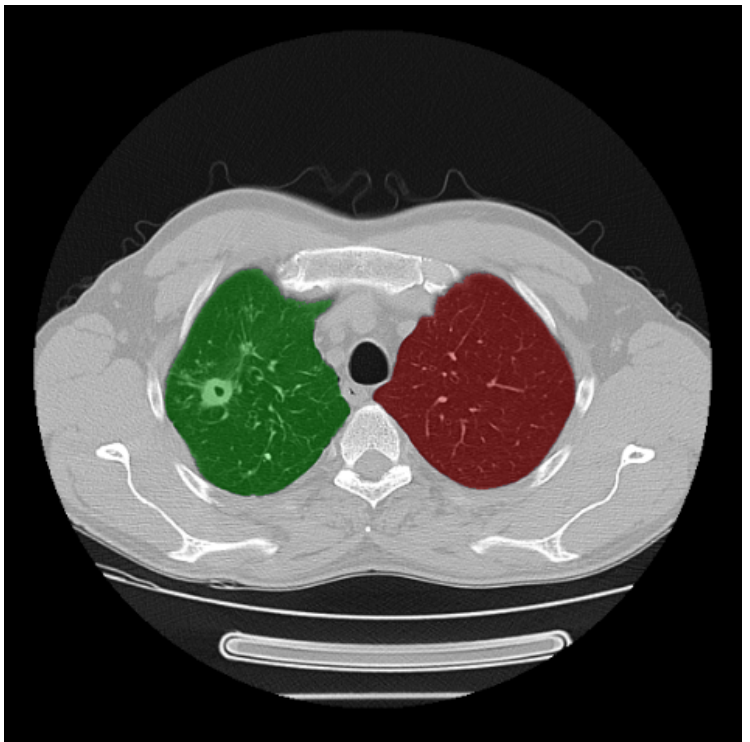
Figure 20. Lung CT scan slice. Source, accessed on 22 September 2022: https://www.imageclef.org/